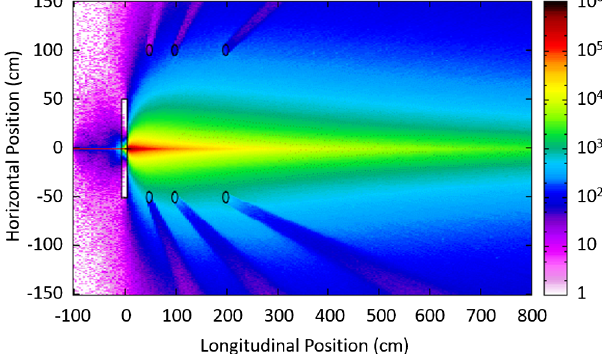
FIG. 4. Model of the radiation field showing a loss on a protection collimator at z ¼ 0 . The color scale gives the dose in eV = g per incident 4-GeV electron (for which 1 eV = g ¼ 250 nGy = J). Six PICs (with axes perpendicular to the page) are inserted at z ¼ 50 , 100, and 200 cm and at r ¼ 50 and 100 cm. Shielding by their steel housings creates the shadows. The dose at these PICs peaks at 170 and 36 μ Gy = J at r ¼ 50 and 100 cm, respectively, and drops slowly with increasing z